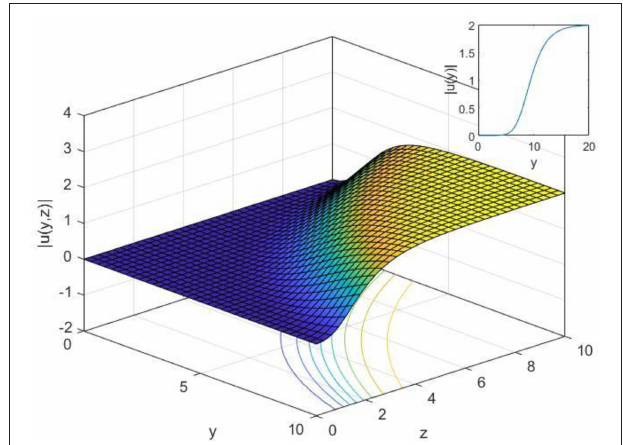
FIGURE 7 | 2-D, 3-D, and contour plot of Equation (27), when t γ 2, α 0.5, β 0.6 and z = = =